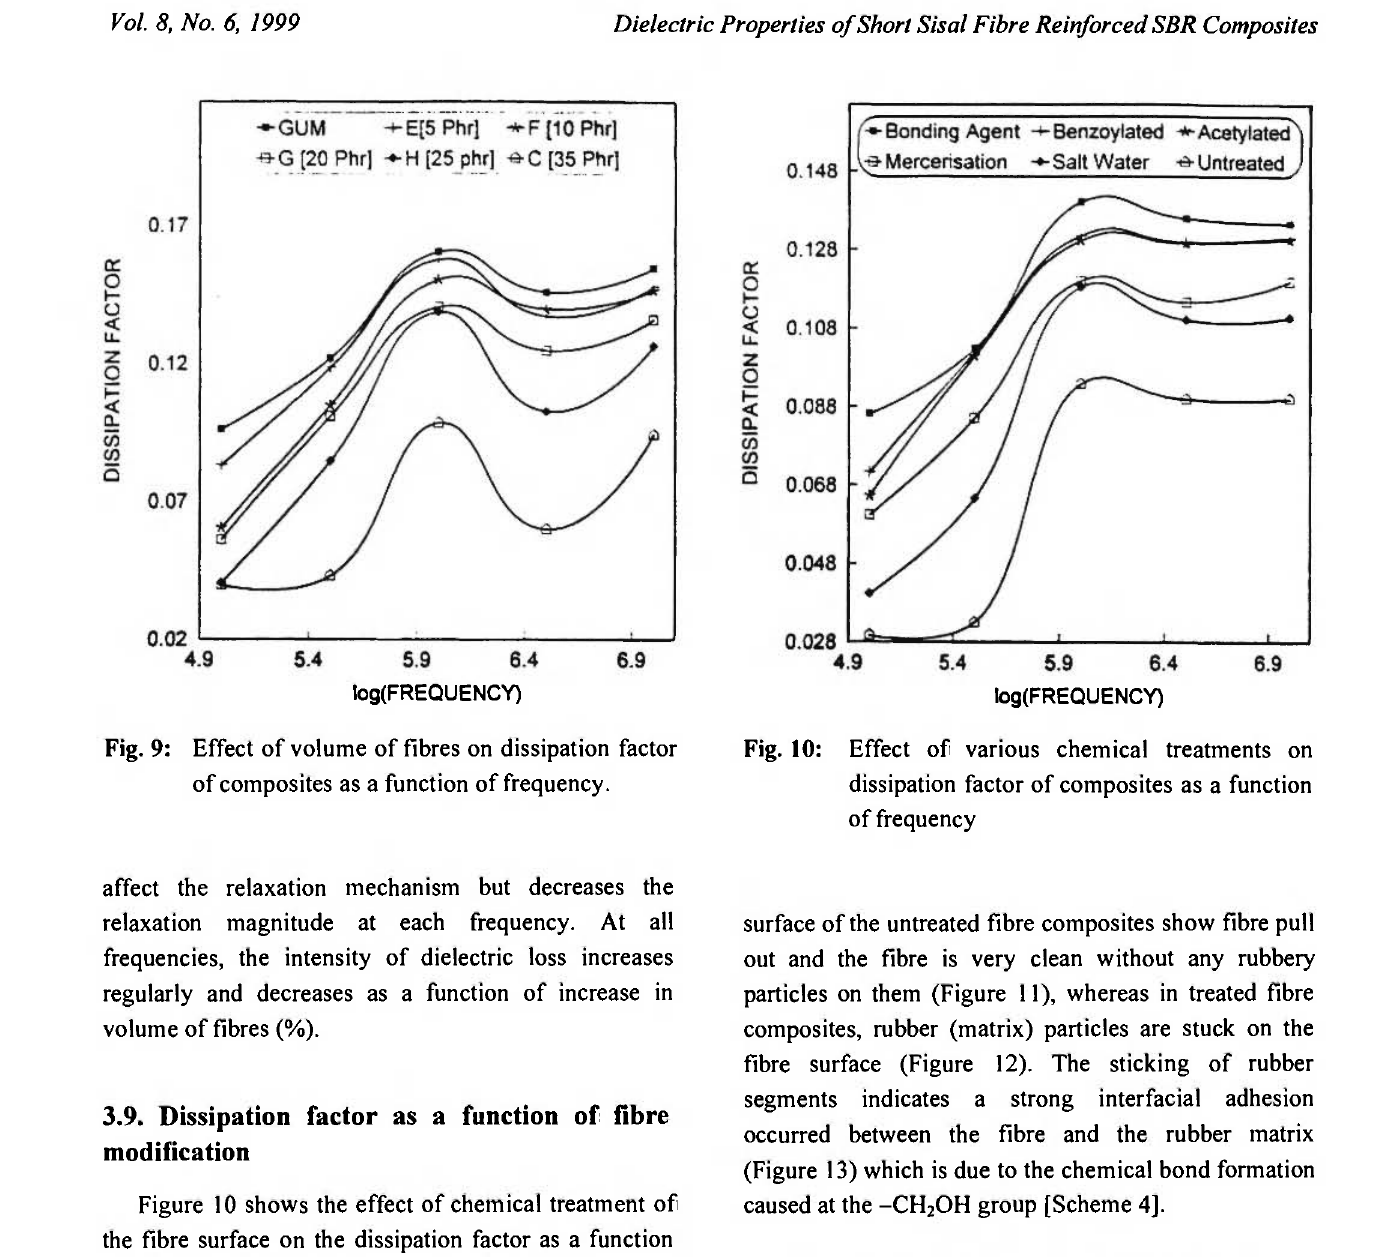
frequency. At all surface of the untreated fibre composites show fibre pull out and the fibre is very clean without any rubbery particles on them (Figure 11), whereas in treated fibre composites, rubber (matrix) particles are stuck on the fibre surface (Figure segments indicates a strong interfacial adhesion occurred between the fibre and the rubber matrix (Figure 13) which is due to the chemical bond formation caused at the -CH 2 OH group [Scheme 4].